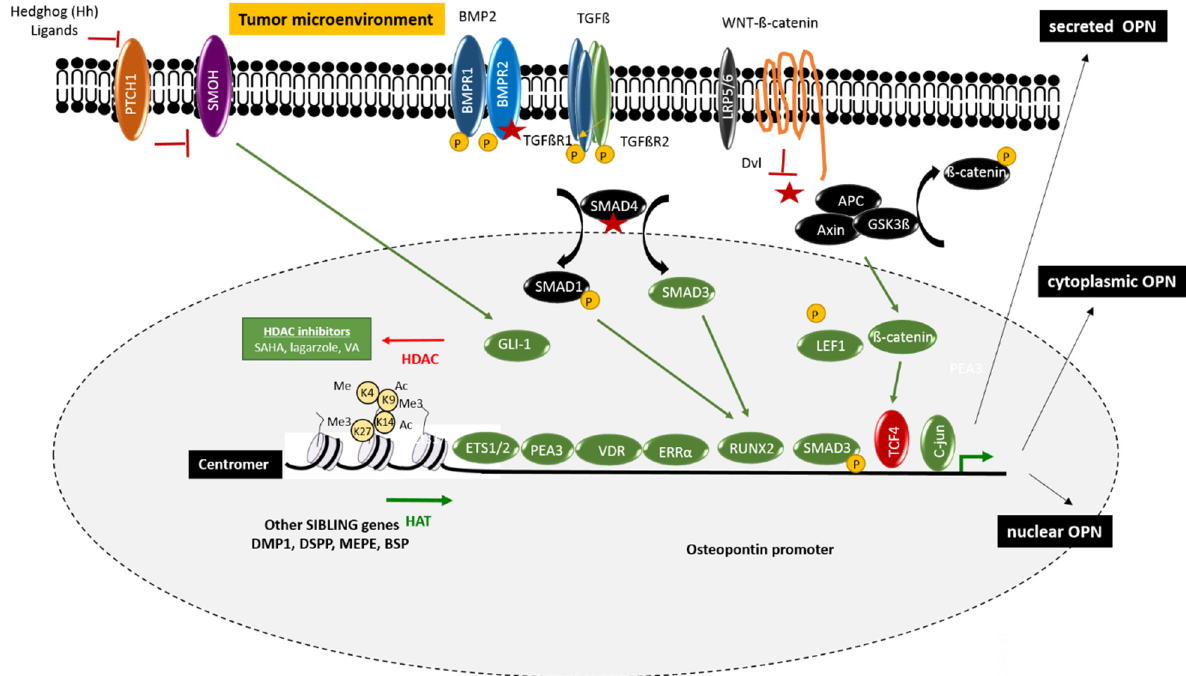
Figure 1. Epigenetic and genetic regulation of the OPN promoter in CRC. The regulation of the osteopontin expression is complex and involves both genetic and epigenetic mechanisms such as promoter methylation, as well as different protein complexes acting on the histones and thereby regulating the compaction of chromatin within the SIBLING gene cluster. The osteopontin promoter also contains numerous binding sites for transcription factors that act in coordination to regulate the transcriptional activity. Some are known to be connected to important CRC signaling pathways, particularly the Wnt pathway, as well as the TGF β pathway and the Hedgehog pathway. The pre-messenger is also subject to alternative splicing generating different isoforms and contains an alternative initiation site leading to the formation of a shorter protein. Osteopontin may be intracellular (nucleus, cytoplasm, and secretory vesicle) or extracellular following secretion. Osteopontin is believed to play a role in the liver both as a matrix protein and as a cytokine mediating signaling between tumor cells, as well as between cells in the tumor environment, such as cancer-associated fibroblasts (CAFs) and tumor-associated macrophages (TAMs), which also secrete osteopontin.